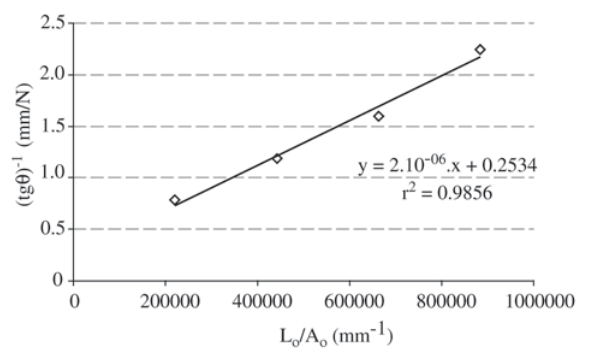
Figure 11. Graphical plot of equation 7 taken from experimental data from Table 5, for glass fibres.